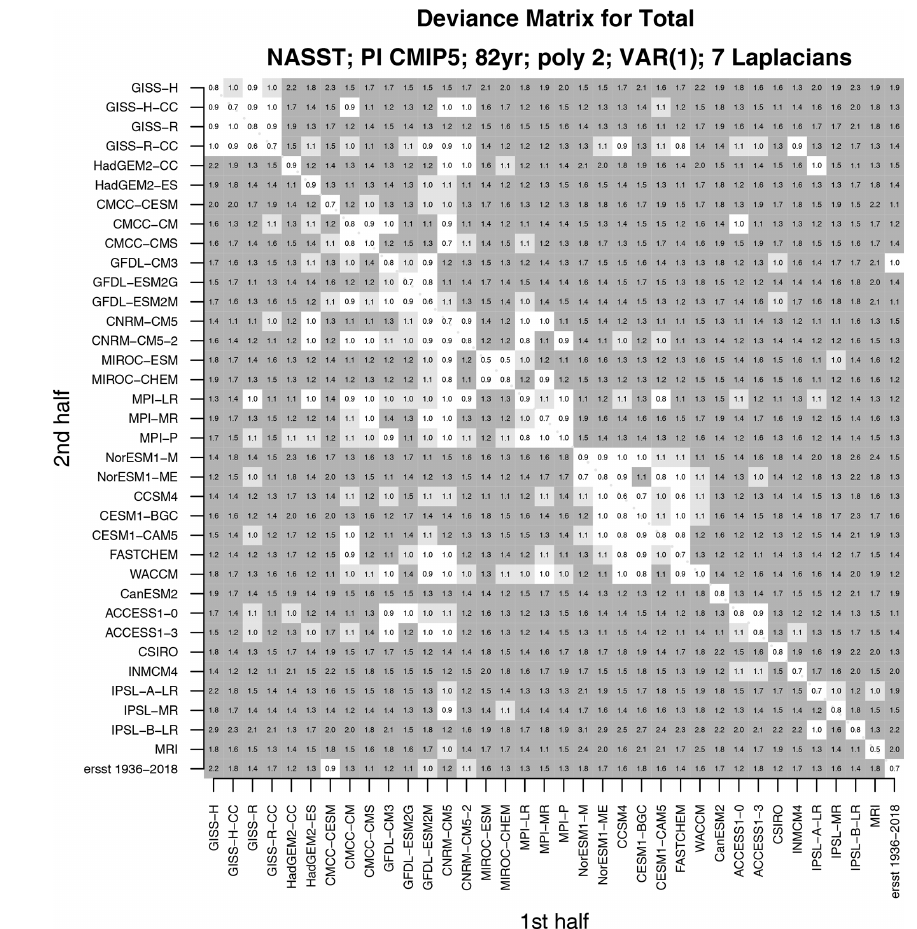
Figure 6. The deviance between two non-overlapping time series from CMIP5 pre-industrial control simulations and observations. The time series are obtained by extracting a continuous 165-year period, regressing out a second-order polynomial, and then splitting the time series in half (82 and 83 years). For observations, the 165-year period corresponds to 1854–2018. The deviance is divided by the 5% significance threshold, so values greater than 1 indicate a significant difference in the VAR model. Light and dark grey shadings highlight values greater than the 5% and 1% significance thresholds. White spaces indicate insignificant differences between VAR